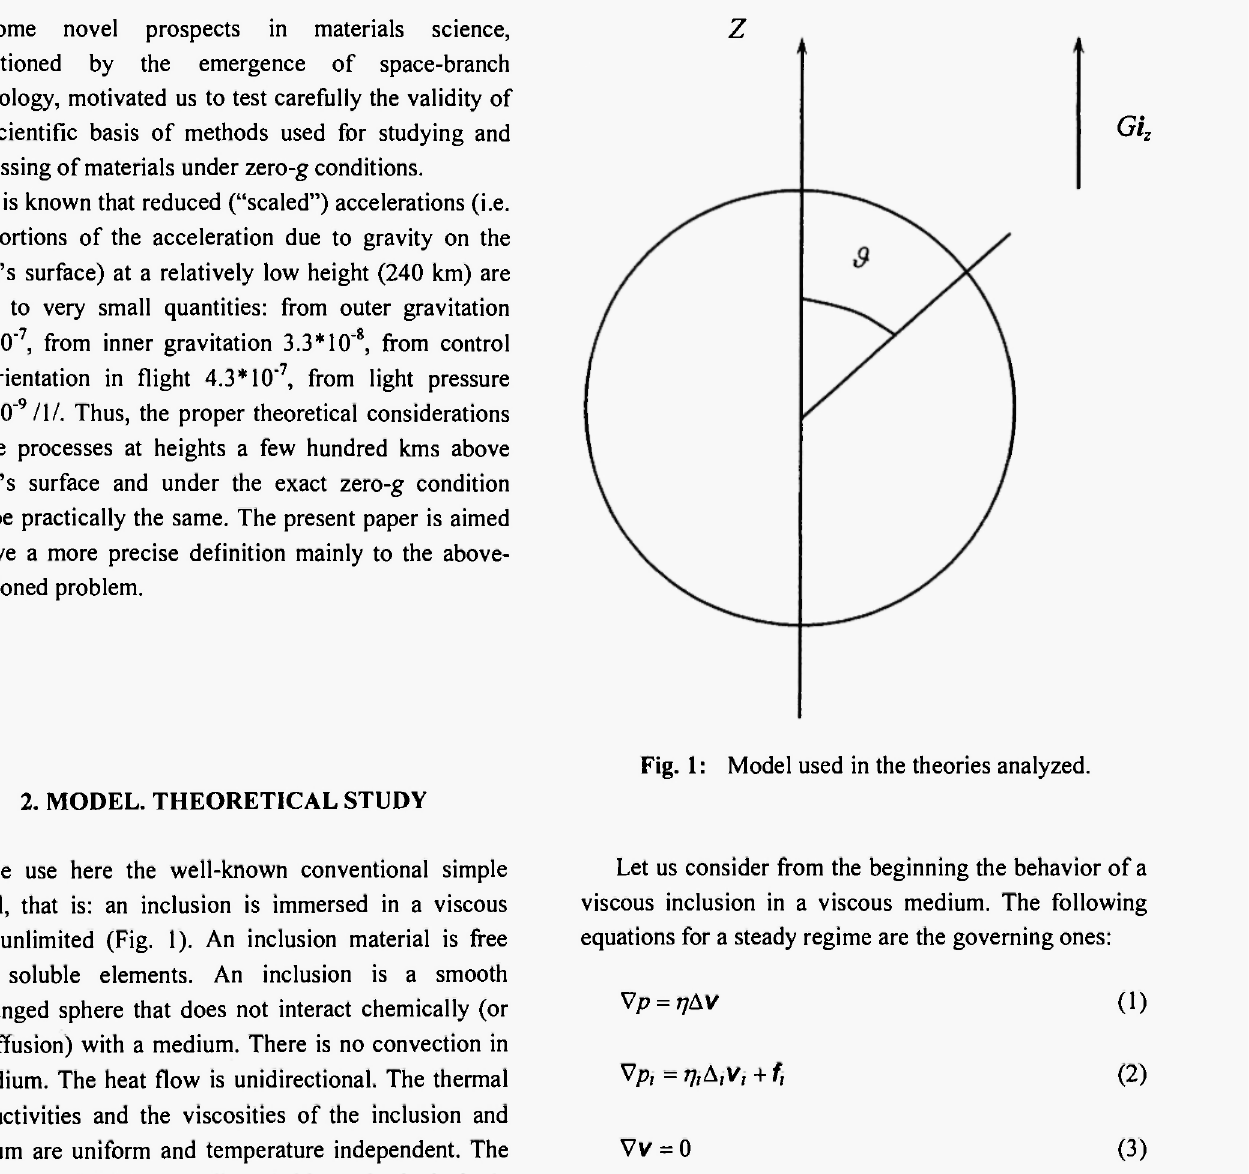
Fig. 1 : Model used in the theories